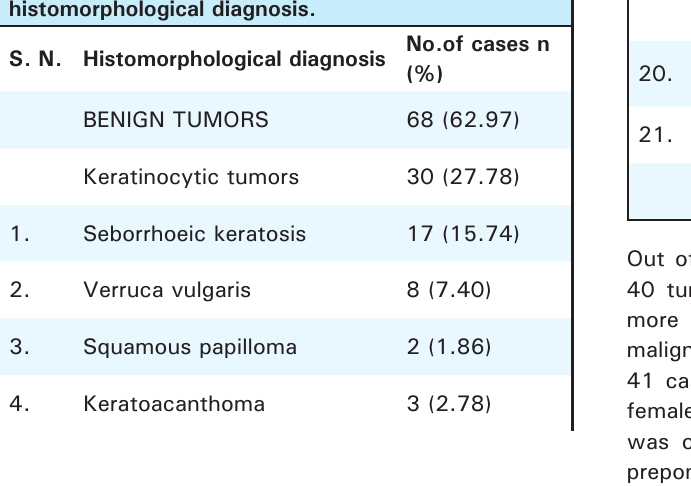
Table 1. Distribution of cases according to histomorphological